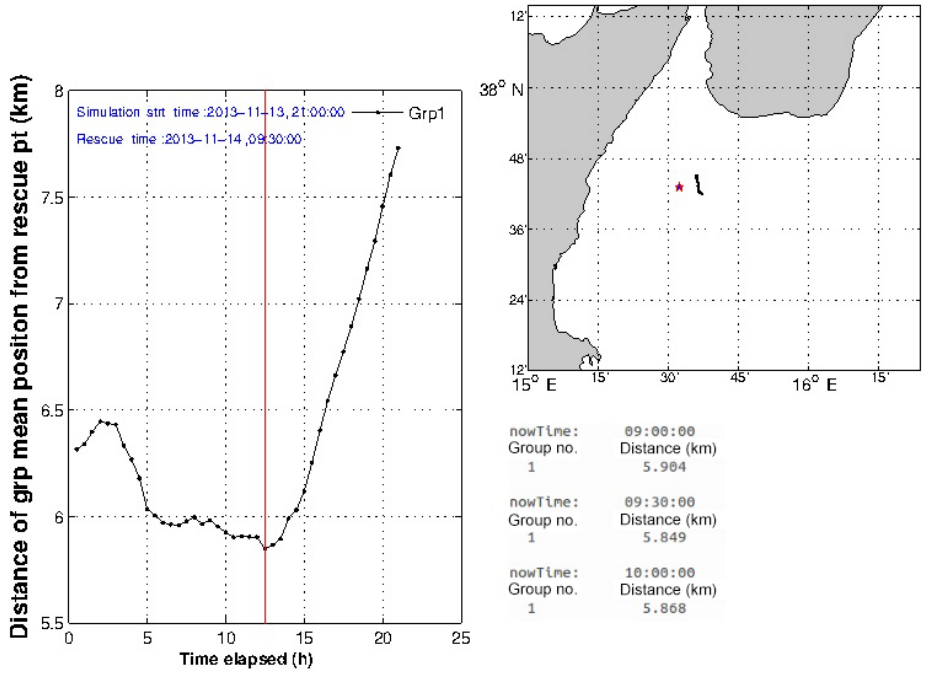
Figure 15. Distance of the mass center of the particles set planted at a known time/point to simulate the trajectory of a dummy in the Sicilian Channel. Again the leeway is calculated by means of the force balance equation. On the upper right side of the picture the trajectory of the mass center throughout the simulation (21h) is visible.